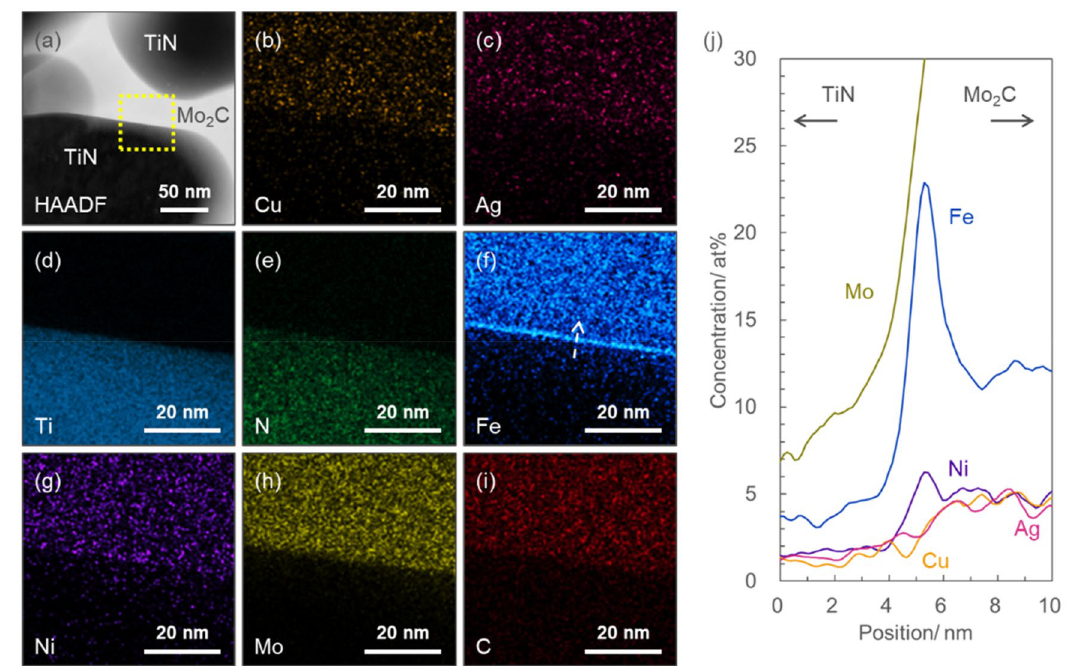
selected area marked in ( a ) by EDS. j Line EDS profile obtained C/TiN grain inter- 2 along the white dashed arrow shown in ( f